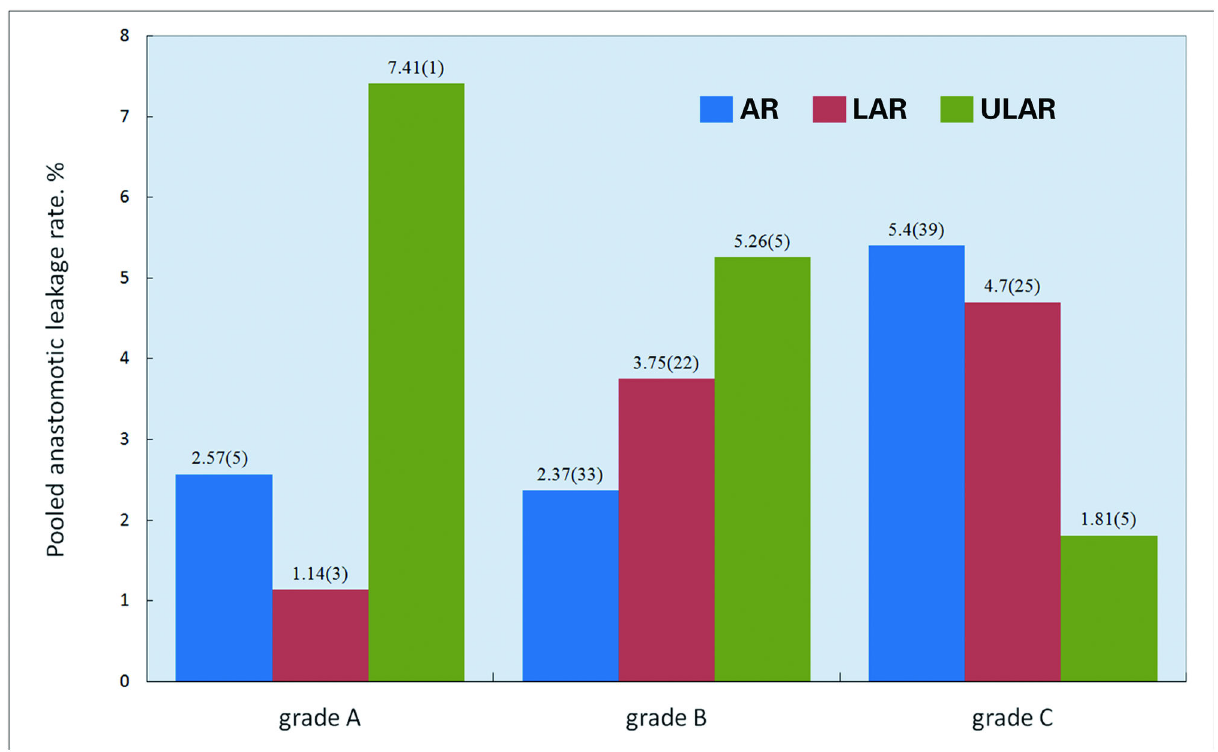
Figure 6. Pooled AL rates of each grade in AR, LAR, and ULAR (the number of reports are presented in brackets). doi: